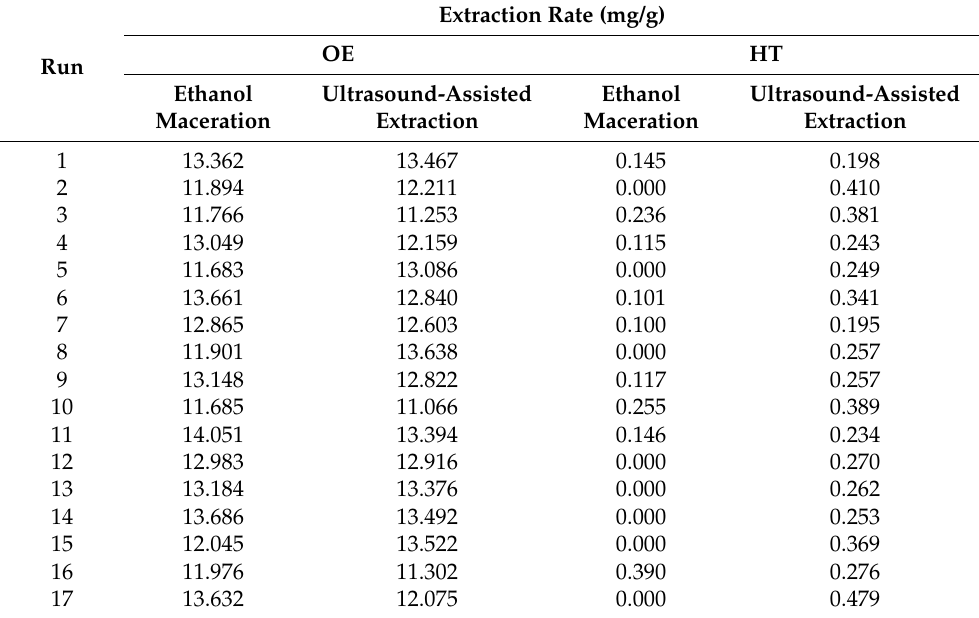
Table 2. Impact of different extraction